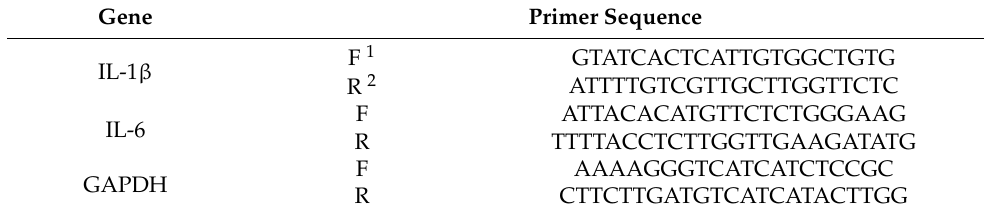
Table 1. Forward and reverse primer sequences for